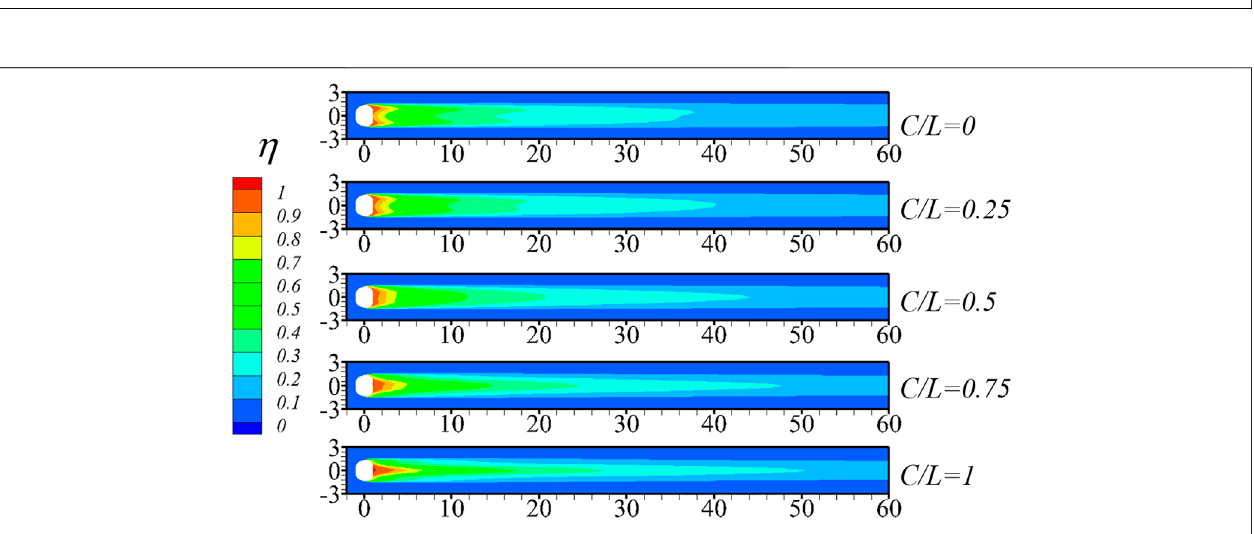
FIGURE 8 | X-direction vorticity contour and streamline at X/D (cid:2) 2 plane in M (cid:2) 0.5 condition.